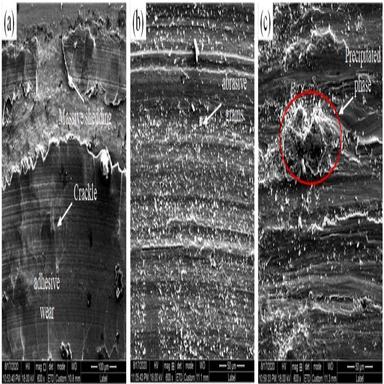
Worn surface morphologies of the surface with different Inconel 625 wire speeds: (a)Ti6Al4V; (b) 25% Inconel + 75%0 Ti6Al4V; (c) 35% Inconel + 65% Ti6Al4V.